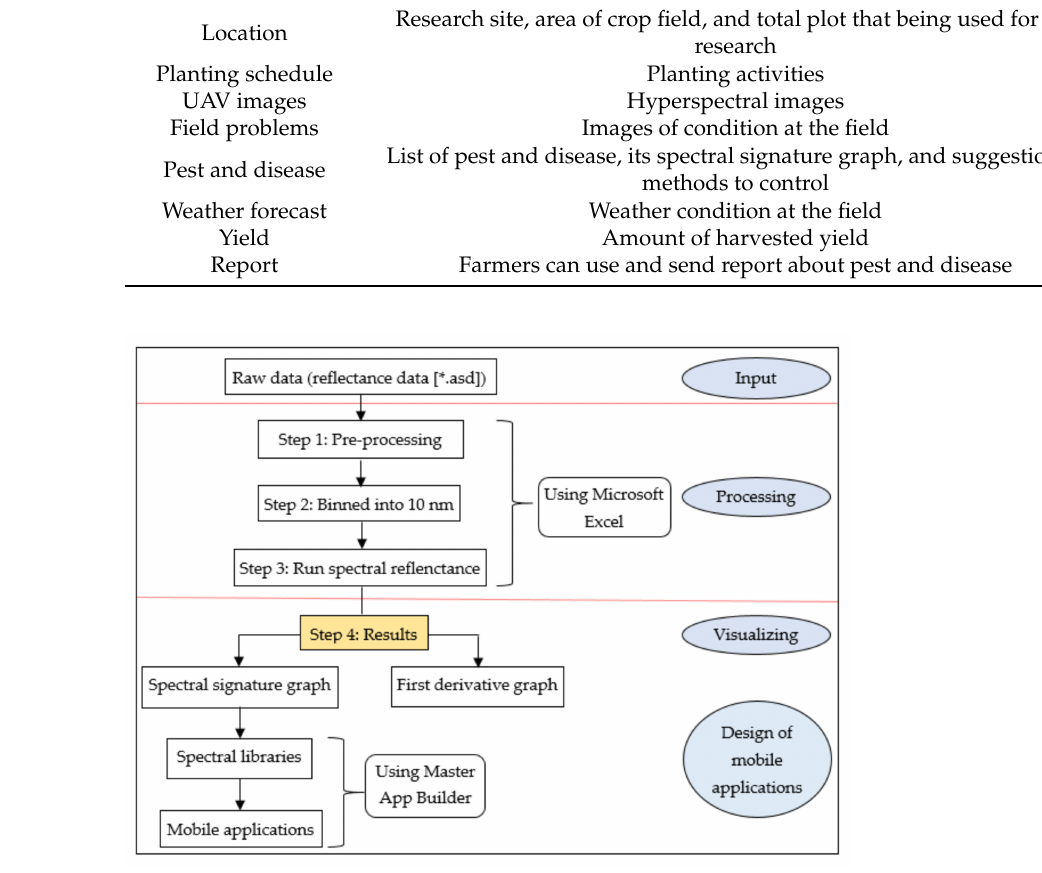
Figure 9. Theoretical framework for generating the spectral signature graph for detecting pests or diseases using mobile